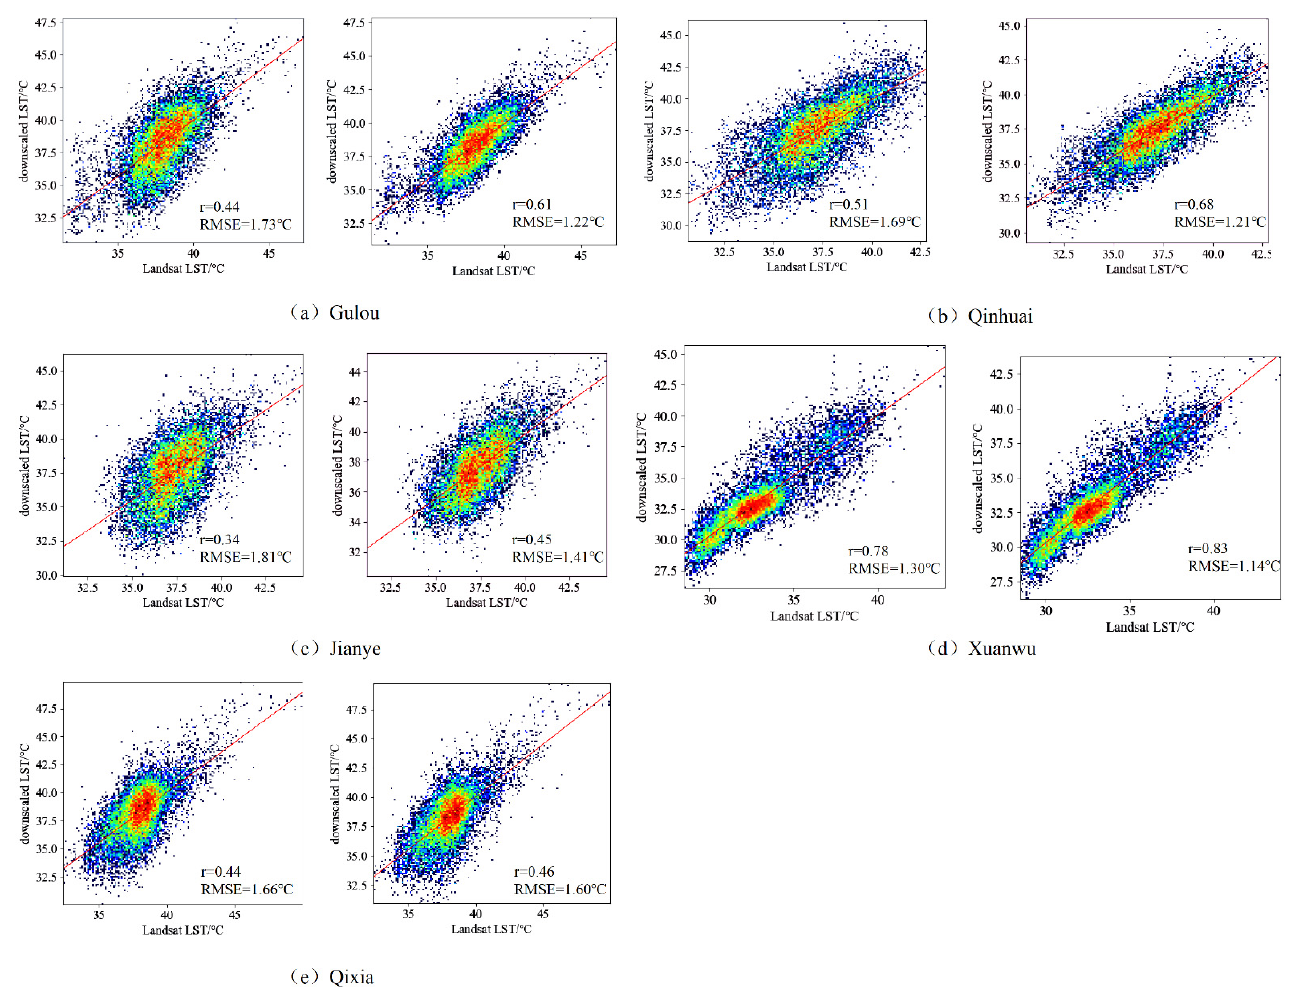
Figure 7. Scatterplot of correlation analysis between downscaled LST and Landsat LST at a spatial resolution of 30 m (downscaled LSTs obtained from SSRFD and SSRFD-M correspond to the left and right panels in a – e ).